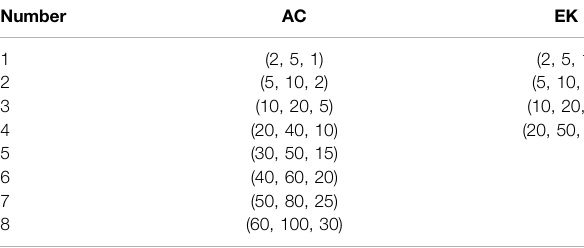
TABLE 1 | WTA bid values (¥, Chinese